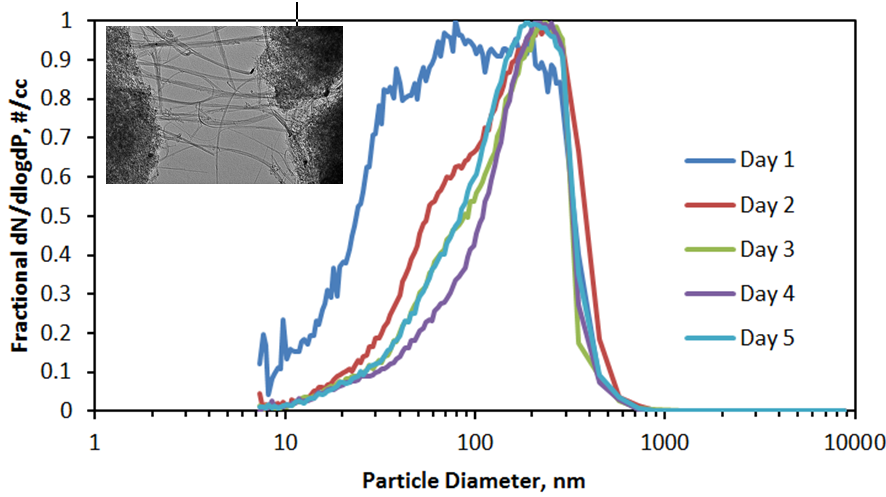
Figure 6. Average of aerosol size distributions measured during 4 h exposure periods (counts normalized to the maximum count), with inset of transmission electron micrograph of double-walled carbon nanotubes (DWCNT) fibers emanating from a fiber